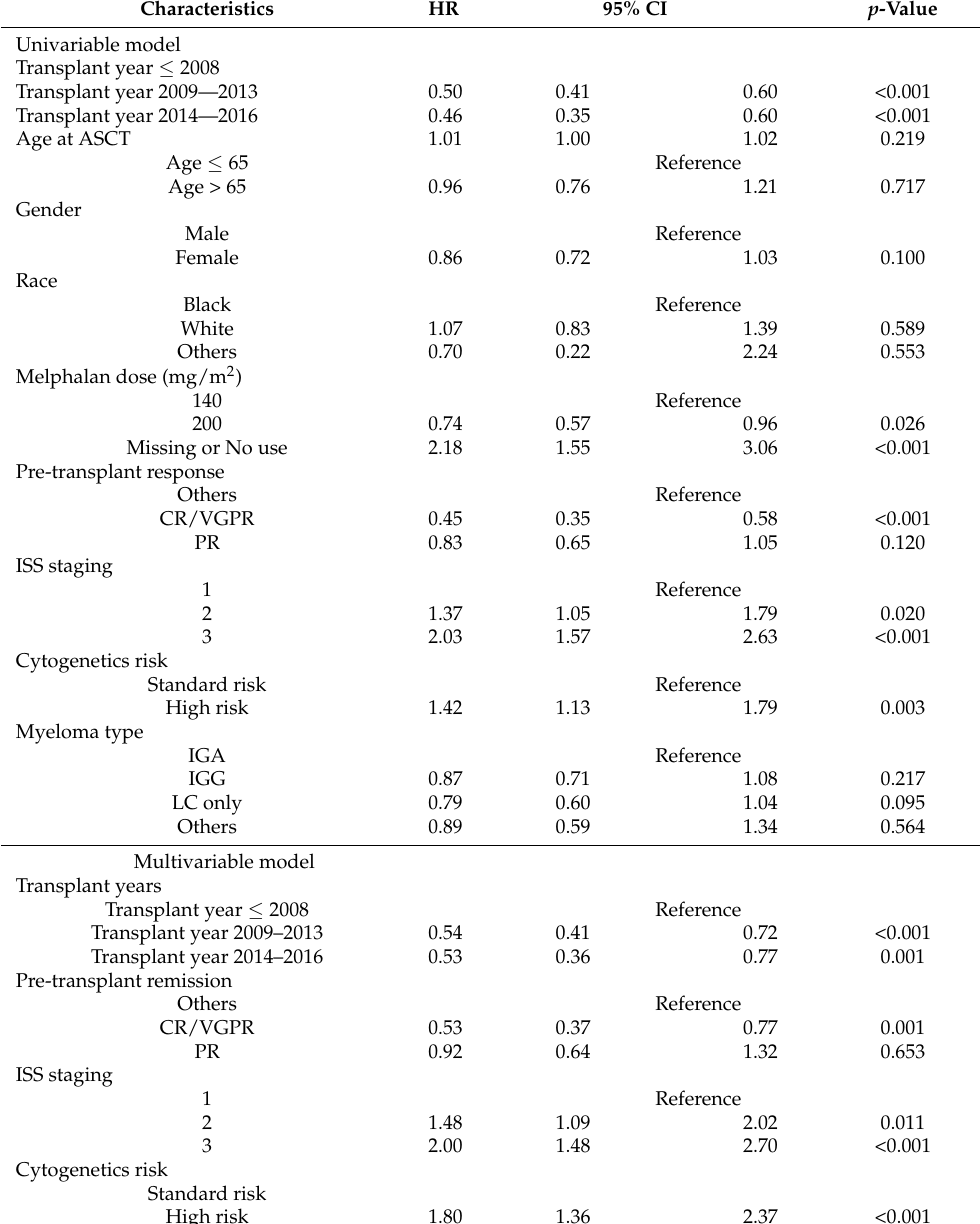
Table 3. Cox Proportional Hazard Model on Risk of